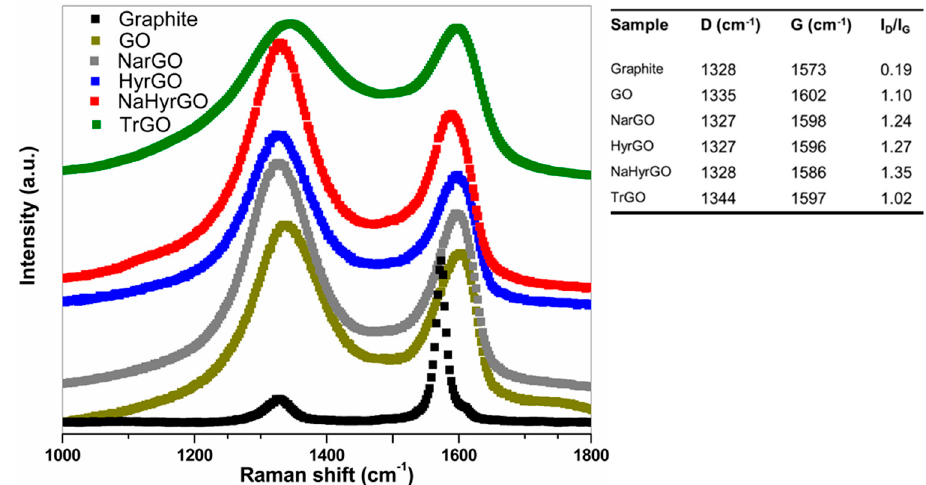
Figure 2. Raman spectra of graphite, GO and different reduced GOs.